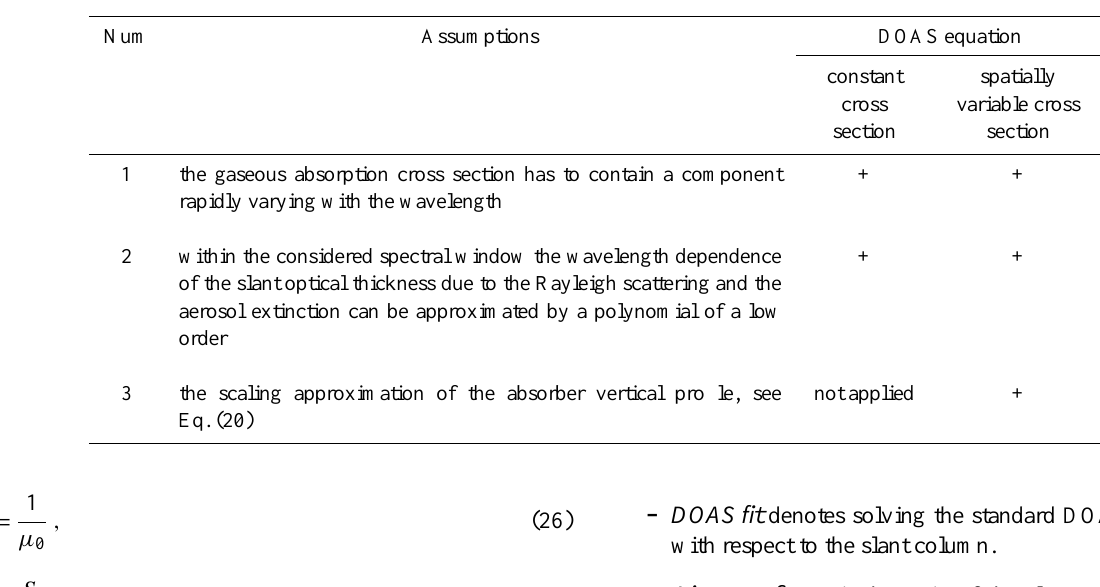
Table 1. Assumptions employed to derive the DOAS equations (13) and (25) suitable for the retrieval of gaseous absorber amounts from observations of the direct solar light transmitted through the atmosphere. Num Assumptions DOAS equation 1 rapidly varying with the wavelength